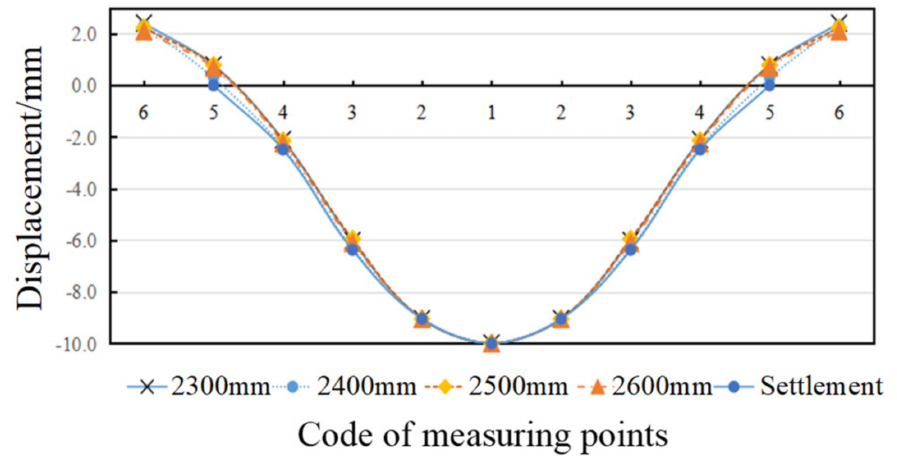
Figure 16. Track slab displacement under different width